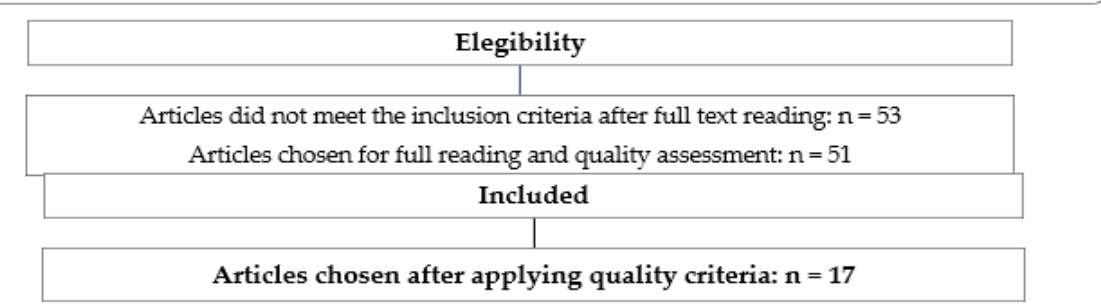
Figure 1. Flowchart of searching and selection process of articles for the systematic review (2007 – 2020).